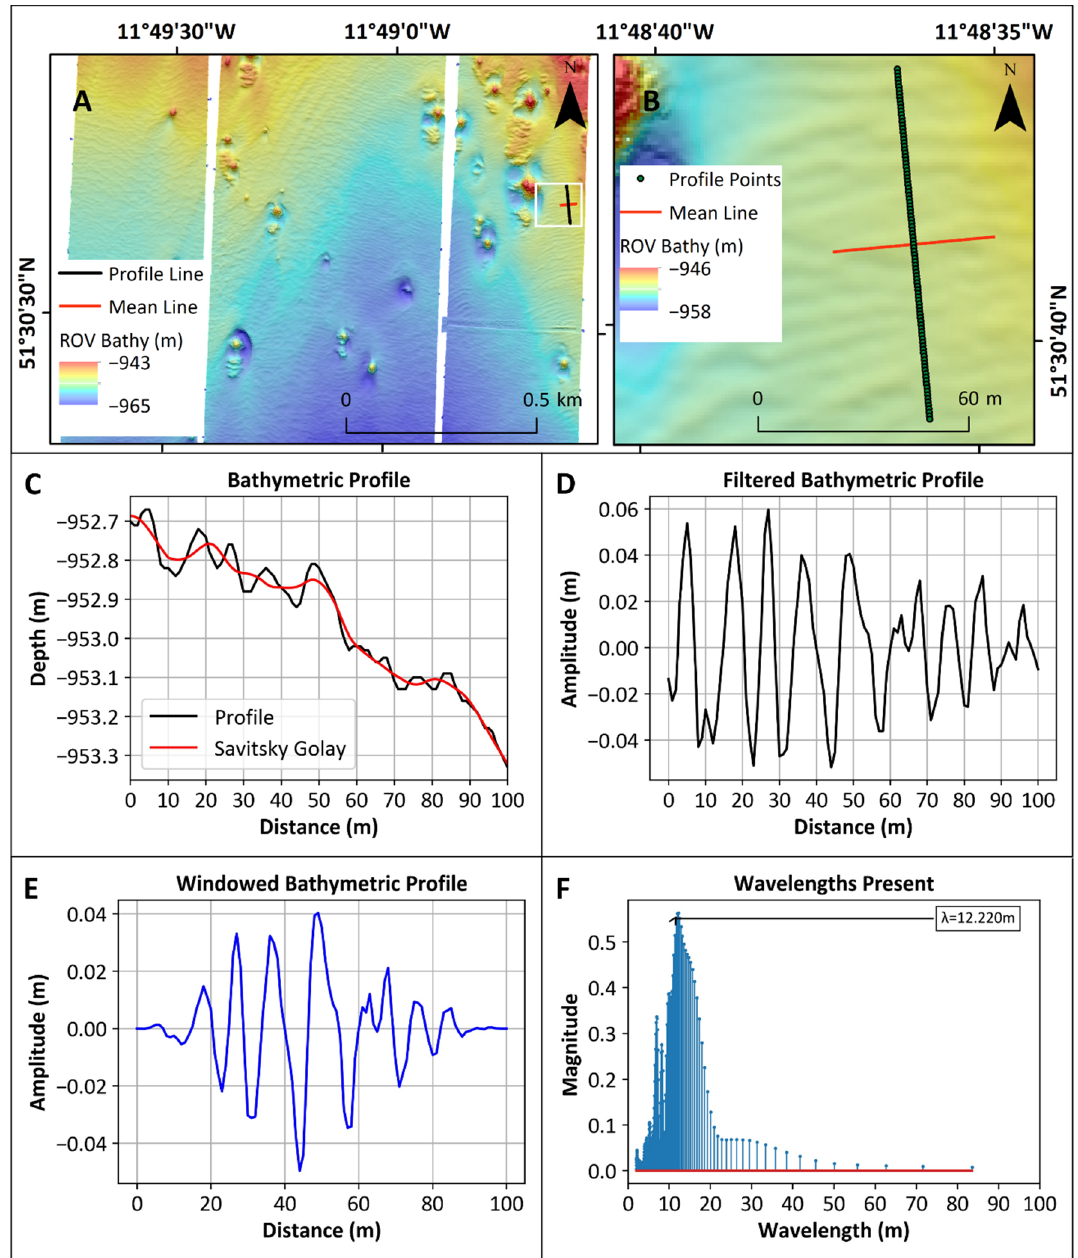
Figure 3. Displaying ( A ) an example of a mean line, its corresponding perpendicular and the extent of ( B ) outlined in white, ( B ) the points generated along the perpendicular line ( C ) the bathymetric profile extracted from the bathymetry with a profile generated by a Savitzky Golay filter with a chosen window of 21 and a polynomial value of 3, ( D ) the bathymetric profile after the subtraction of the Savitzky Golay filter profile, ( E ) the filtered bathymetric profile with a window function applied, and ( F ) a Fast Fourier Transform of the windowed profile providing a spectral view of the wavelengths present in the profile after the removal of the Savitzky Golay filter.